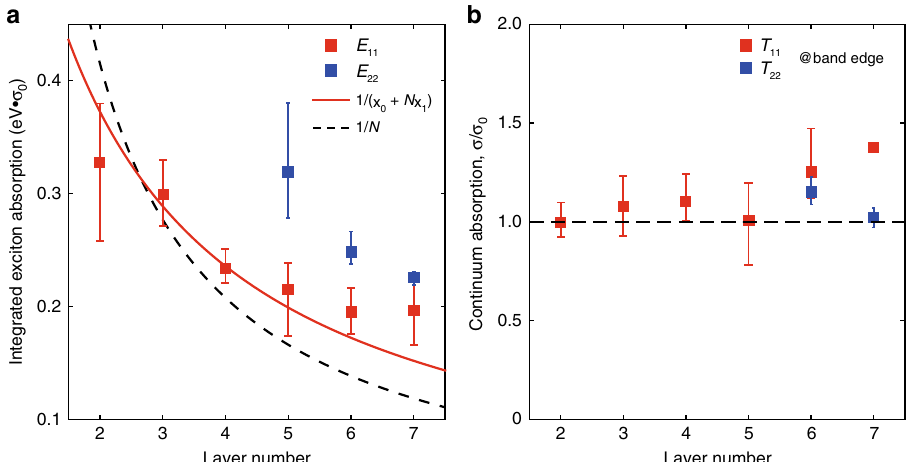
Fig. 3 Exciton and continuum absorption in few-layer BP. a The frequency-integrated conductivity σ I of the 1 s exciton as a function of layer number, in the unit of eV· σ 0 . For each layer number, at least three samples were measured, the squares denote the average values. The solid curve is the fi tting to the E 11 data using the relation σ I = h /( χ 0 + N χ 1 ), with χ 0 and χ 1 describing the screening effect from the PDMS substrate and single-layer BP, respectively. h is the only fi tting parameter, extracted to be 5.78 eV· σ 0 ·Å. The dashed curve shows the 1/ N relation for guideline. b The continuum height of each subband transition near the corresponding band edge ( ħ ω ≈ E g ) is plotted as a function of layer number. The continuum absorption nearly shows a constant value, independent of the material thickness. The black dashed line indicates the well-known universal conductivity σ 0 = e 2 /4 ħ for guideline. Data are extracted from Fig. 2 with error bars indicating sample-to-sample